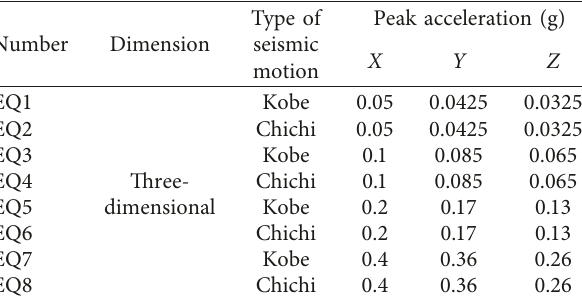
Table 6: Input motion characteristics.